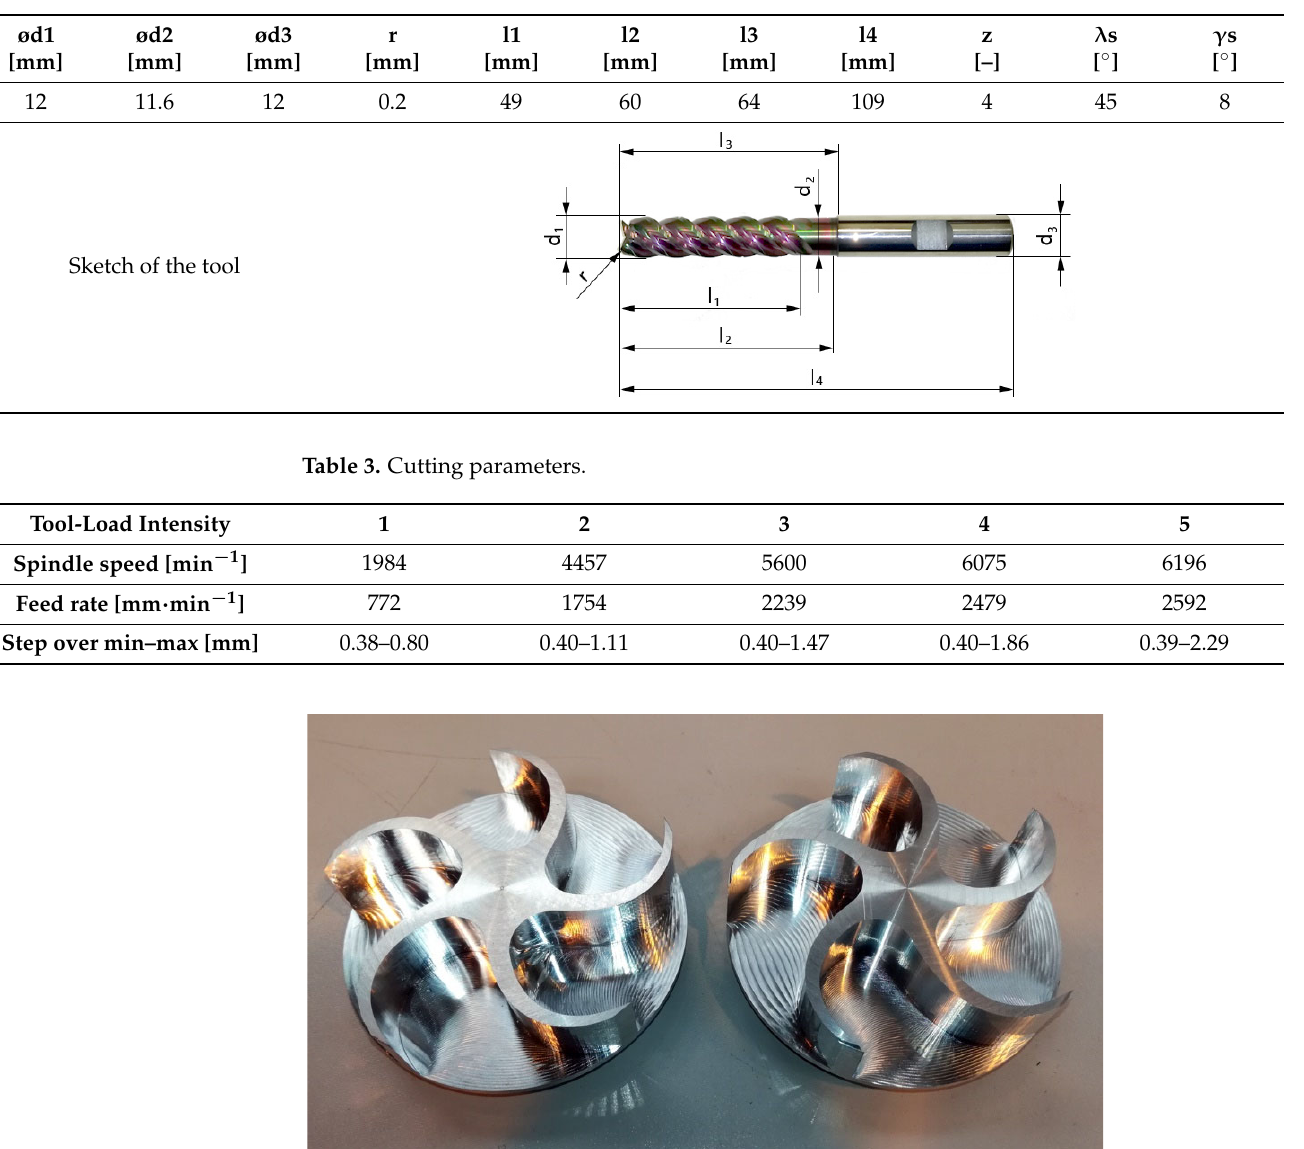
Table 2. Parameters of the tool [20].